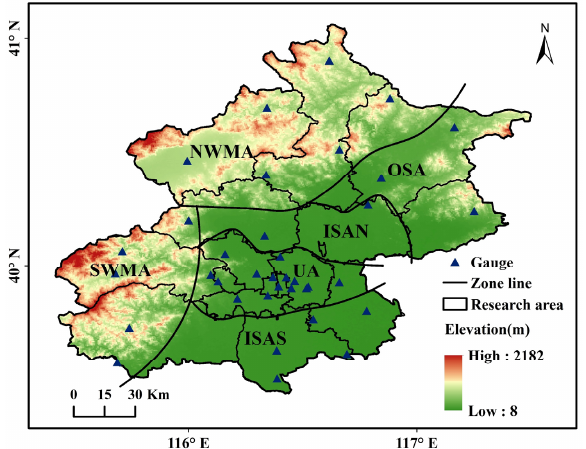
Figure 1. Locations of the rainfall stations in the six subregions of Beijing superimposed over a topographic map.